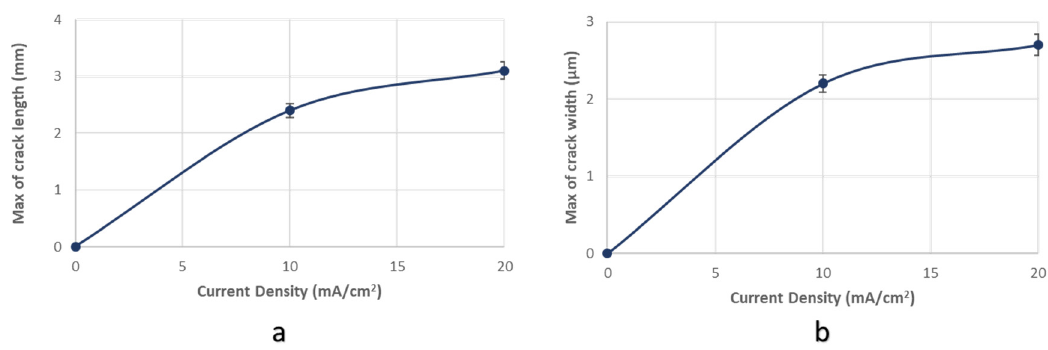
Figure 10. ( a ) maximum crack length and ( b ) maximum crack width of surficial microcracks in conjuction with the applied current density during in situ hydrogen charging process and slow strain rate bending loading.